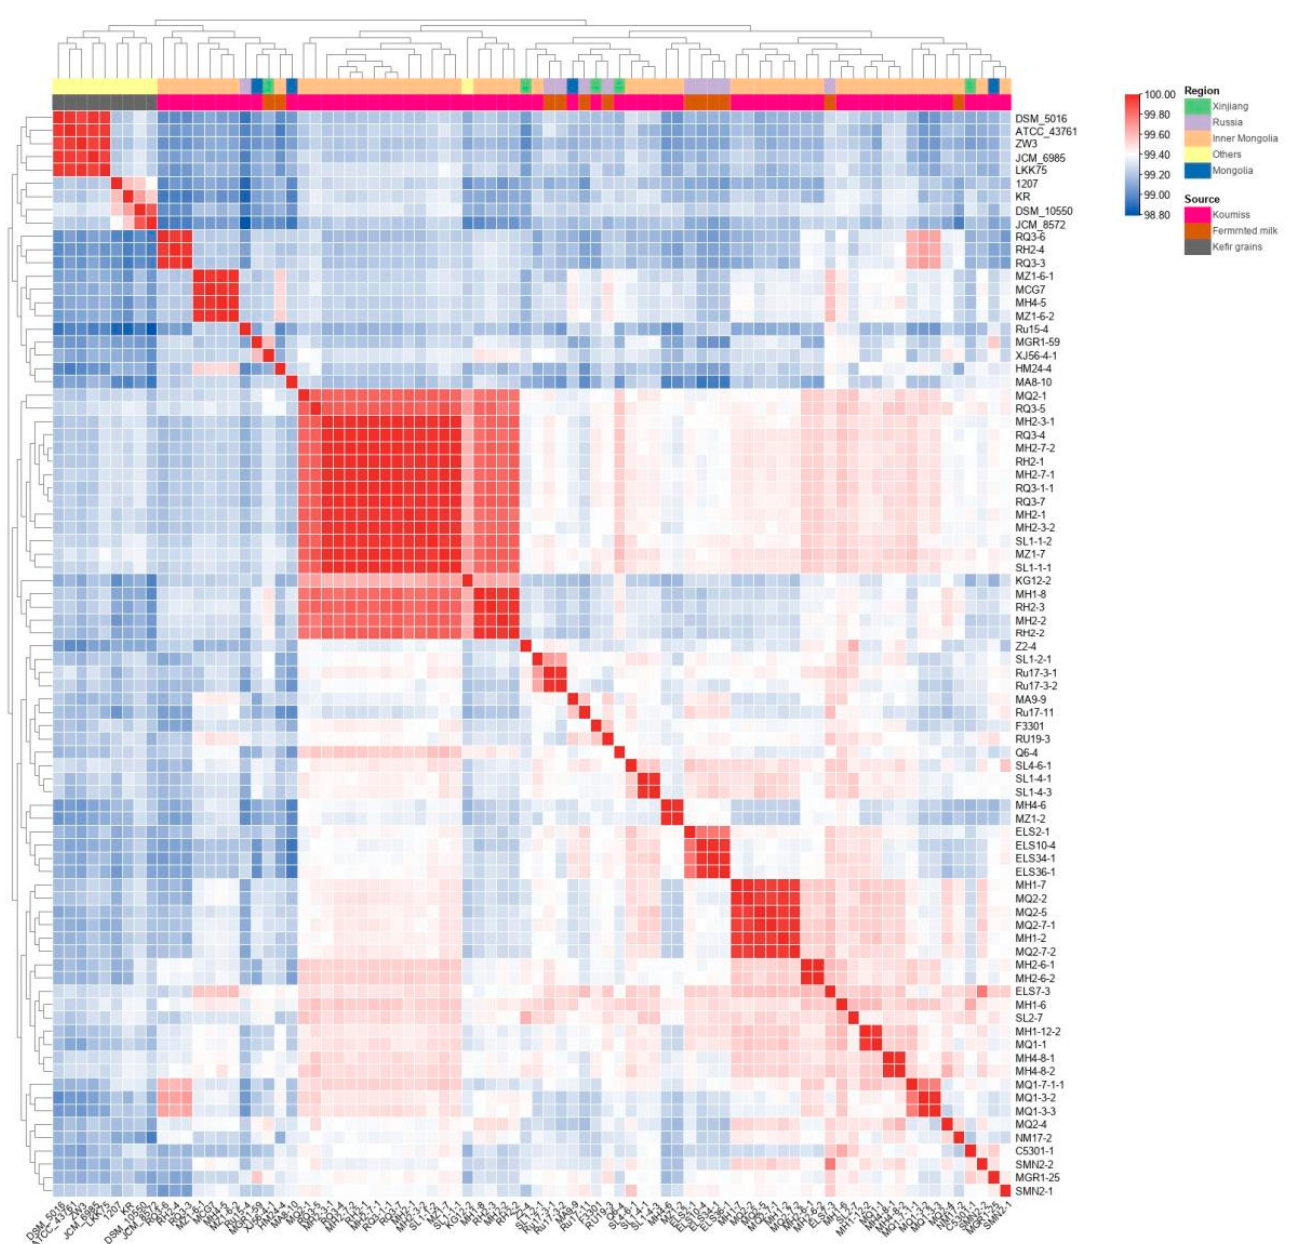
Figure 1. ANI calori fi c diagram of 82 L. ke fi ranofaciens strains .